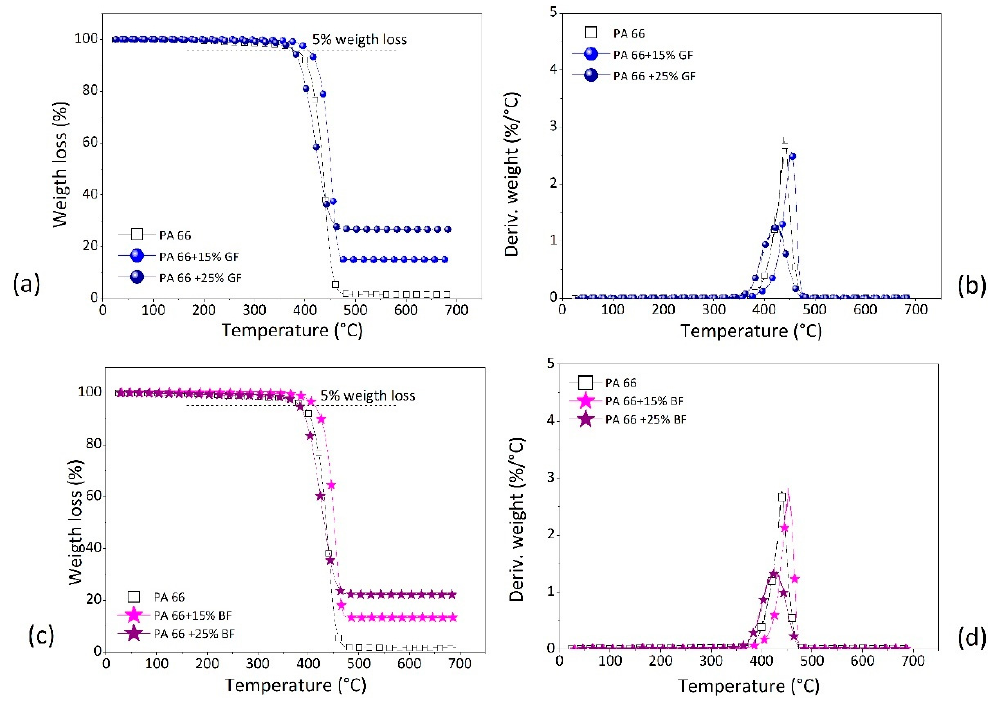
Figure 1. TGA thermograms of ( a ) GF/PA66 and ( c ) BF/PA66 composites, and DTGA of ( b ) GF/PA66 and ( d ) BF/PA66 and ( d ) BF/PA66 composites.